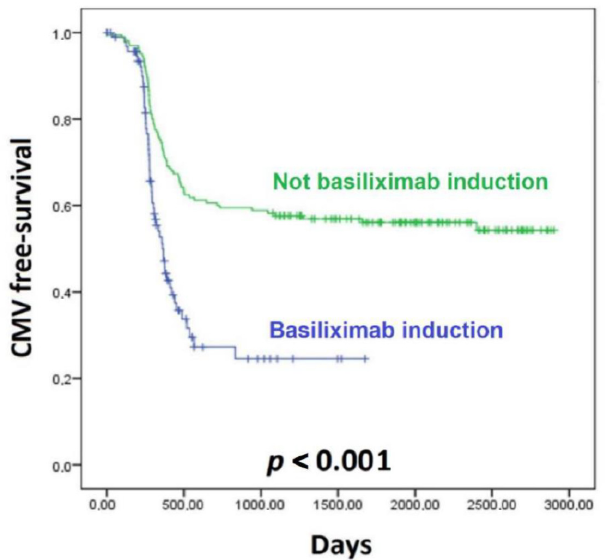
Figure 2. Basiliximab induction. The CMV infection rate was lower in the group of patients with basiliximab induction ( p < 0.001).